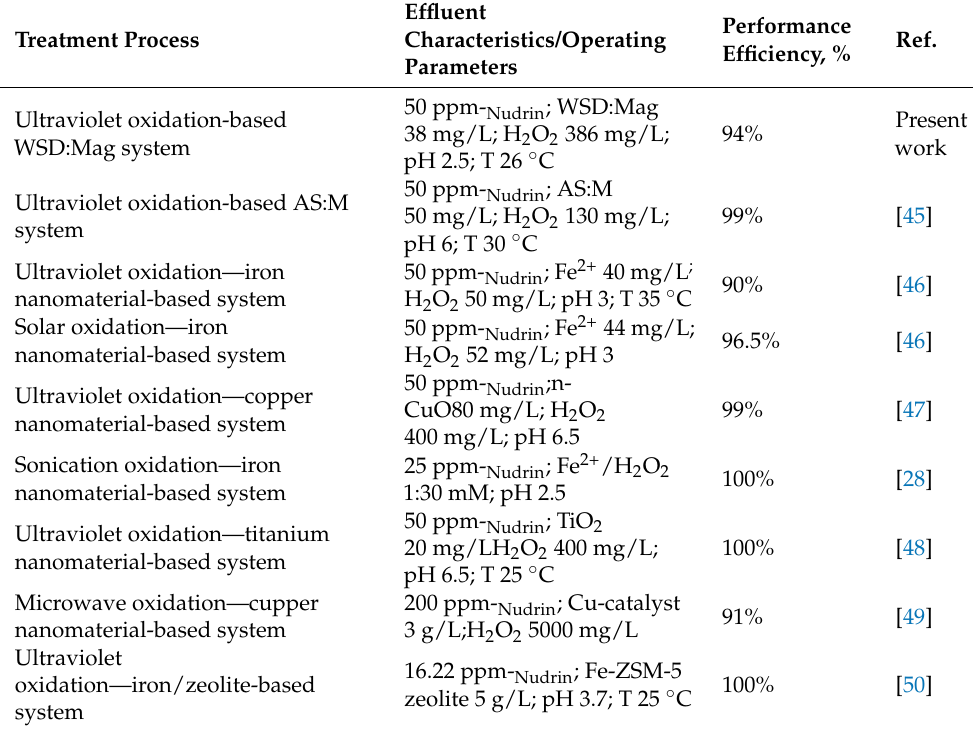
Table 6. Comparison of different treatment methodologies with WSD:Mag-based oxidation systems for Nudrin remediation